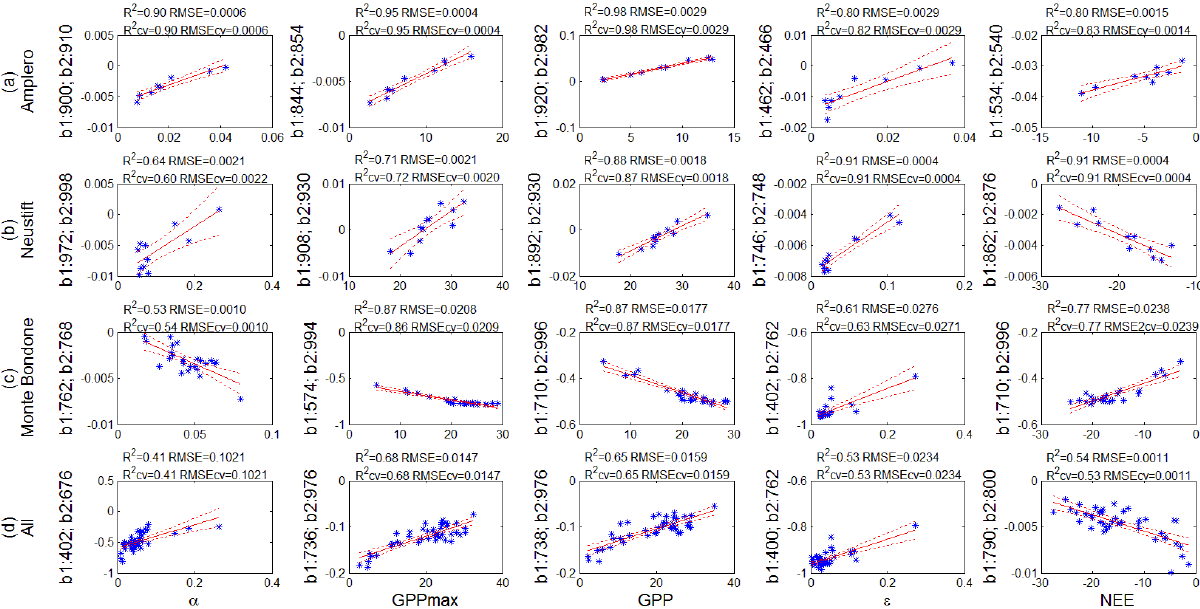
Figure 6. Results of linear correlation analysis for α , GPP max , midday averaged GPP, ε and NEE, on the one hand, and selected best NSD- type indices for (a) Amplero, (b) Neustift, (c) Monte Bondone (both study years pooled) and (d) all sites pooled on the other. R 2 – coefficient of determination; RMSE – root mean square error; R 2 cv – cross-validated coefficient of determination; RMSE cv – cross-validated root mean square error. The solid red lines indicate the fitted models, and the dotted red lines represent the 95% upper and lower confidence